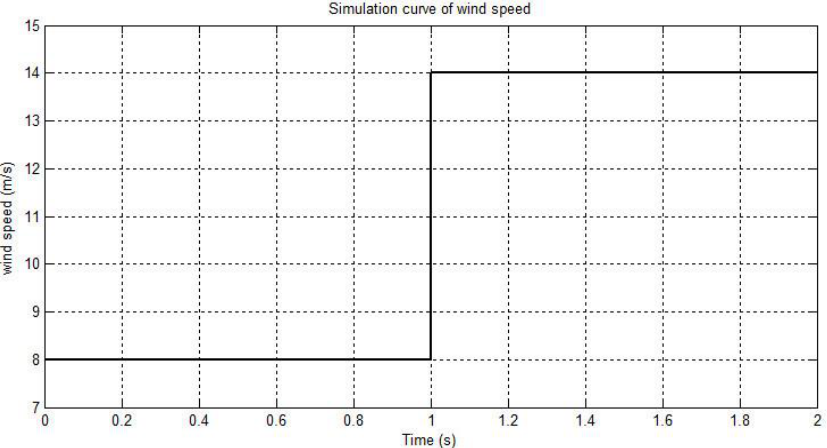
Figure 6. Wind speed simulation curve.